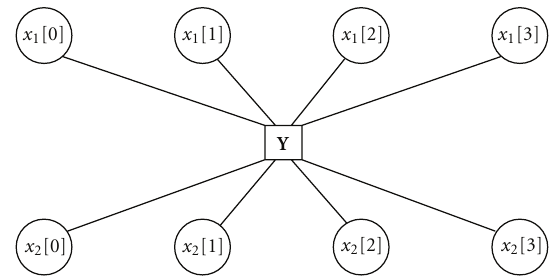
Figure 5: Factor graph of a MIMO-ISI channel with joint Gaussian approximation, N T =